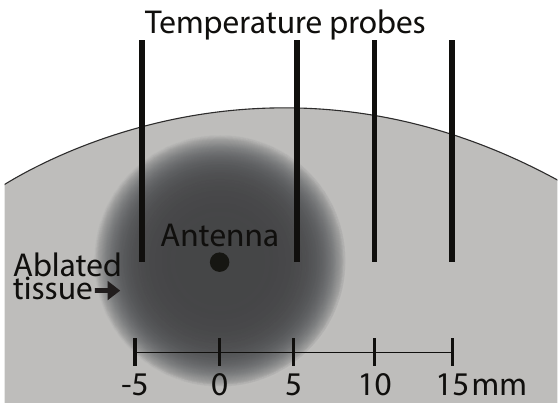
Figure 3. Schematic showing measurement locations relative to the MWA antenna. In this cross-sectional view, the ablation antenna is oriented perpendicular to the plane of the page. The temperature probes are shown as vertical black lines. The tips of the temperature probes are positioned along a horizontal line perpendicular to the longitudinal axis of the antenna and spaced in 5-mm increments away from the antenna. Dielectric spectroscopy measurements and samples for histological analysis were taken from these same temperature measurement locations. The dark region represents an example of ablated tissue.